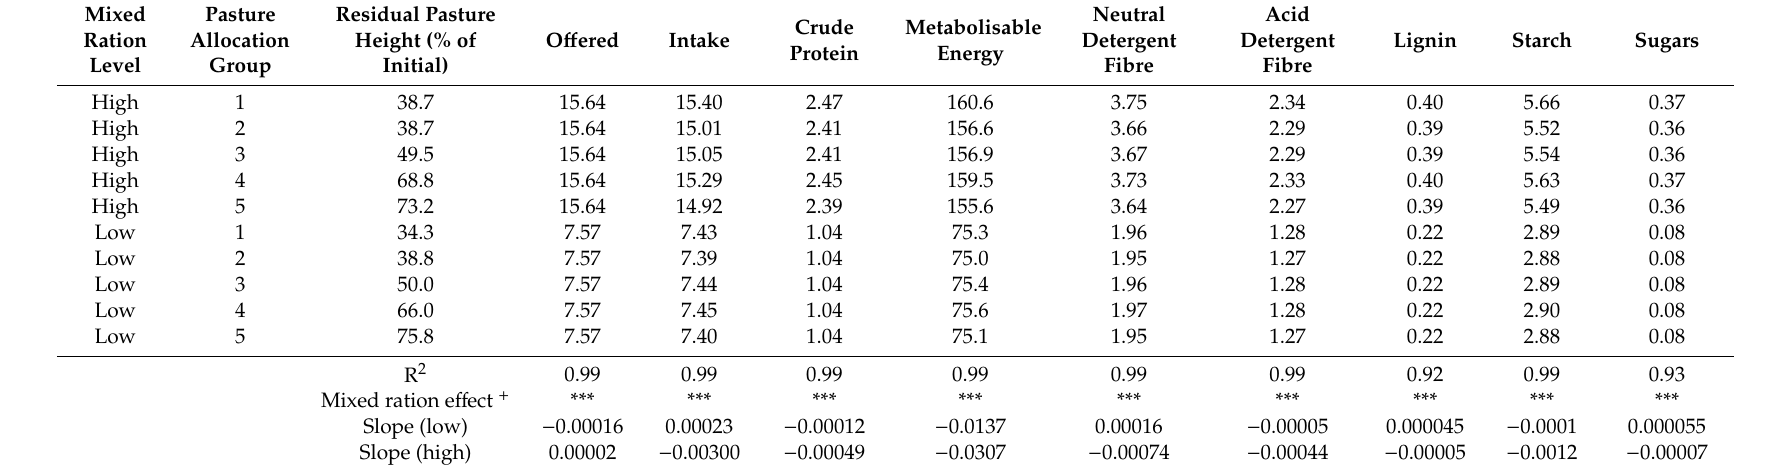
Table 6. The mixed ration o ff ered and consumed, and nutrient (kg dry matter (DM) / cow / day) and metabolisable energy (MJ / cow / day) intake of the consumed mixed ration for each treatment